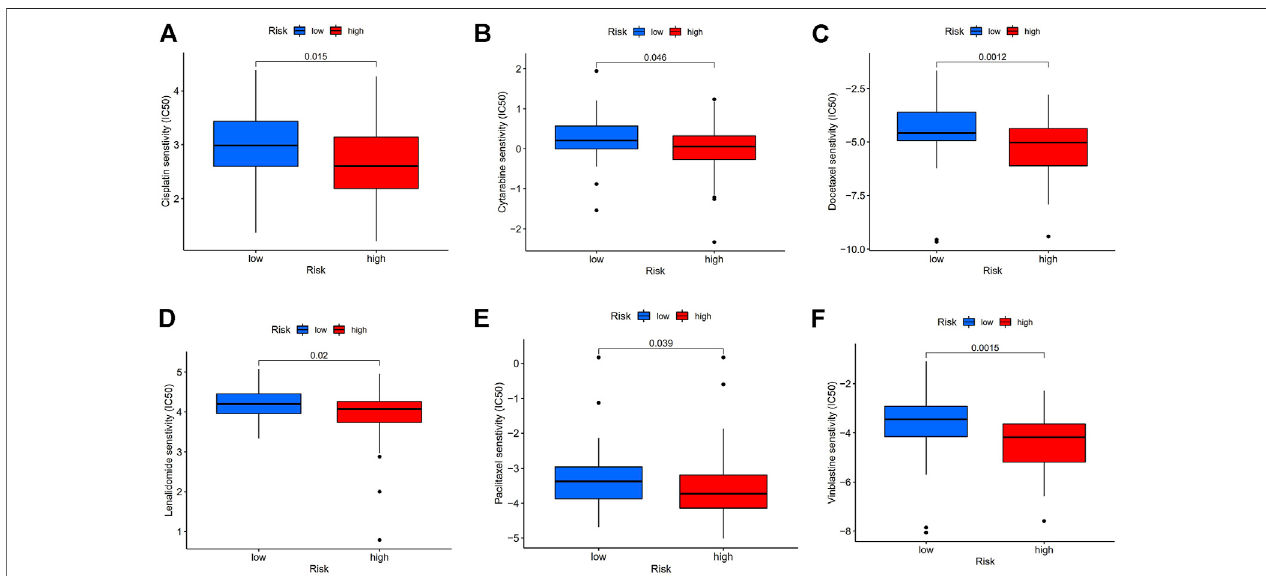
FIGURE8| Chemotherapyandimmunotherapyresponse. (A – F) :SensitivitytoCisplatin,Cytarabine,Docetaxel,Paclitaxel,Vinblastine,andLenalidomideinhighor low-risk group shown in box plot.